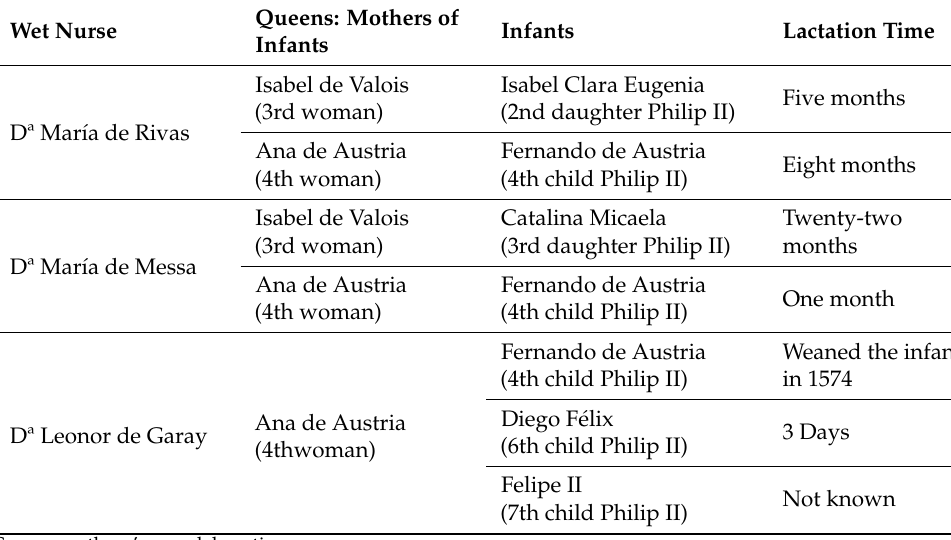
Table 3. Wet nurses who breastfed different infants born to Philip II.